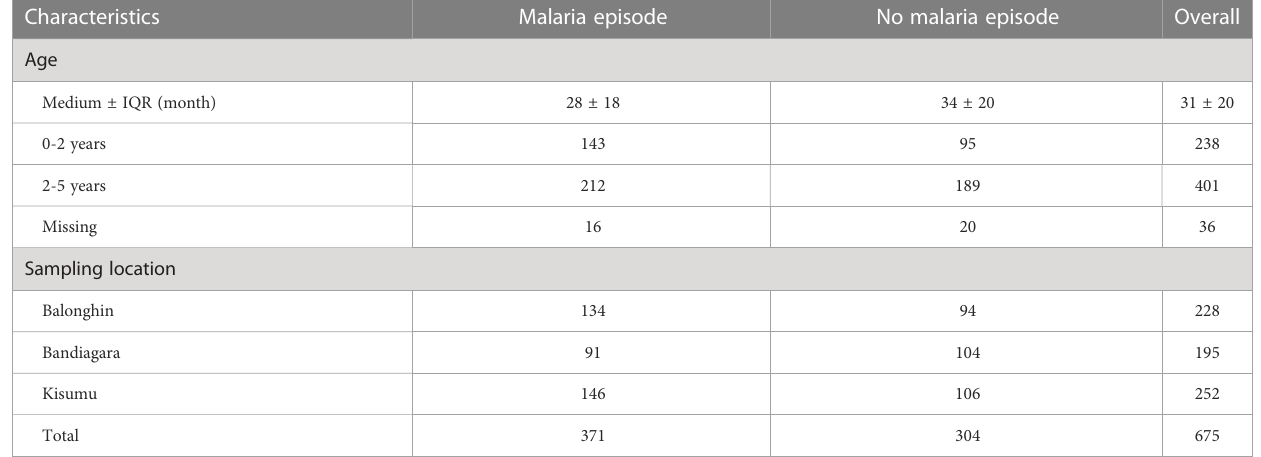
TABLE 1 Participant characteristics.